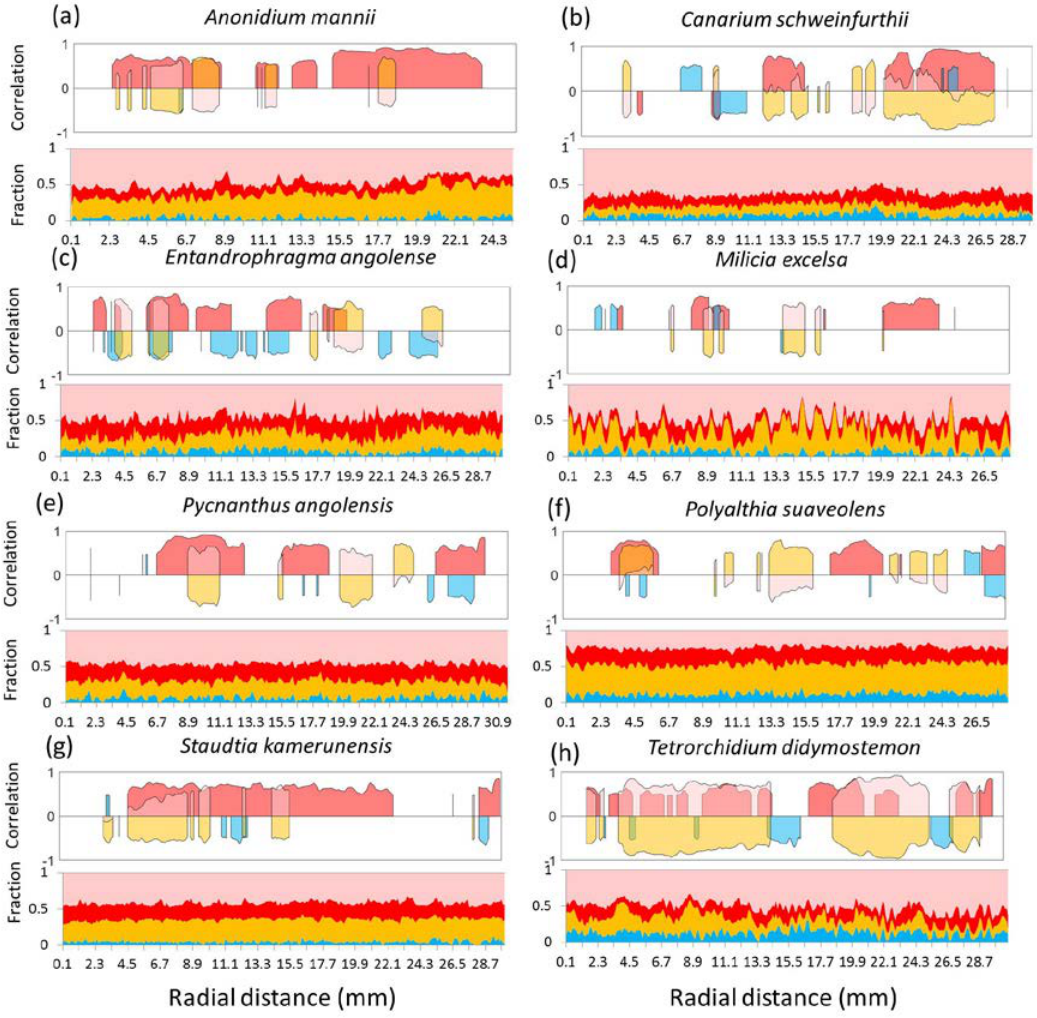
Figure 5. Moving significant ( p < 0.05) Pearson correlation plots (window width = 30 density values) in upper panel with fibre wall fraction (red), fibre lumina (pink), parenchyma (orange), and vessels (blue). Bottom panel shows fractions with fibre walls (red), fibre lumina (pink), parenchyma (orange), and vessels (blue). Species shown are ( a ) Anonidium mannii , ( b ) Canarium schweinfurthii , ( c ) Entandrophragma angolense , ( d ) Milicia excelsa , ( e ) Pycnanthus angolensis , ( f ) Polyalthia suaveolens , ( g ) Staudtia kamerunensis , and ( h ) Tetrorchidium didymostemon.